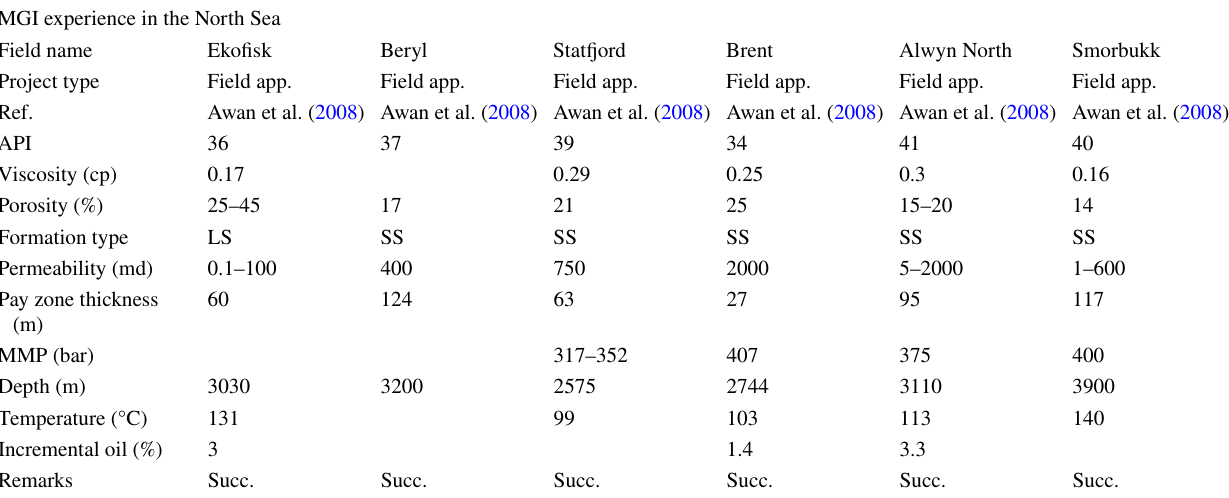
Table 4 Reservoir data for MGI projects in the North Sea MGI experience in the North Sea